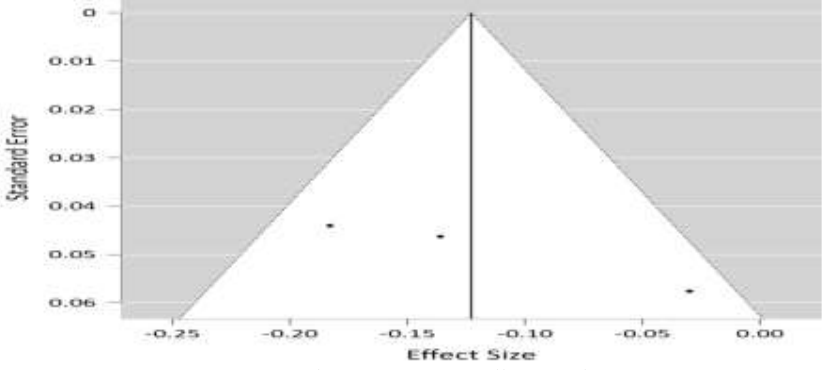
Figure 29 . Funnel plot of standard error and effect size of meta-analysis of Motivation for stimulation and Emotional stability